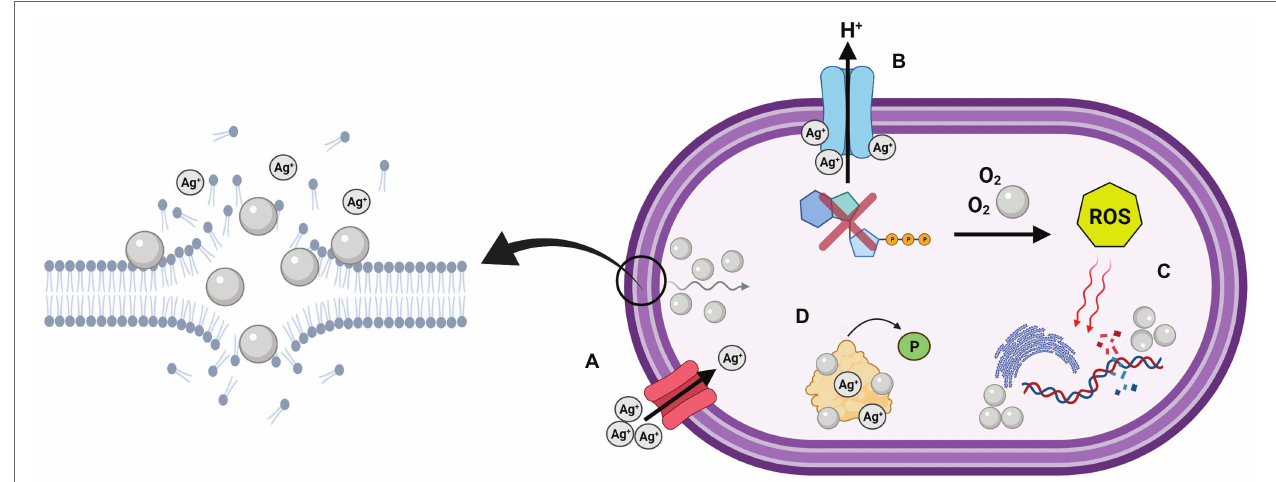
FIGURE 1 | Graphical depiction of the multi-target antibacterial mechanisms of silver nanoparticles (NAg) on the cell surface and cell cytoplasm. (A) Adhesion and “pitting” of the cell membrane, and subsequent internalisation of NAg, along with Ag + passage through outer membrane porin (OMP) channels, (B) uncoupling of respiratory chain by Ag + , (C) damage to biomolecules by reactive oxygen species (ROS) and intracellular NAg, and (D) disruption of cell signalling through protein dephosphorylation. Created in BioRender. Adapted from Dakal et al.